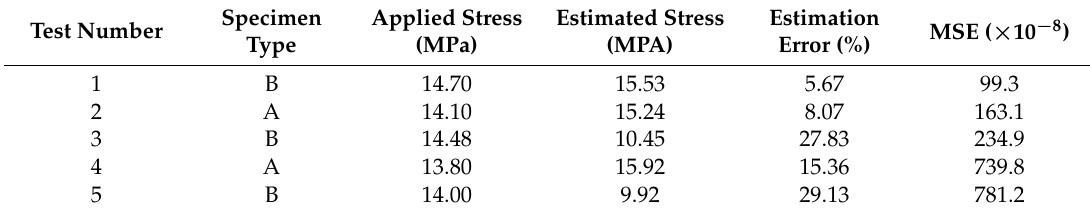
Table 2. Stress estimation results.